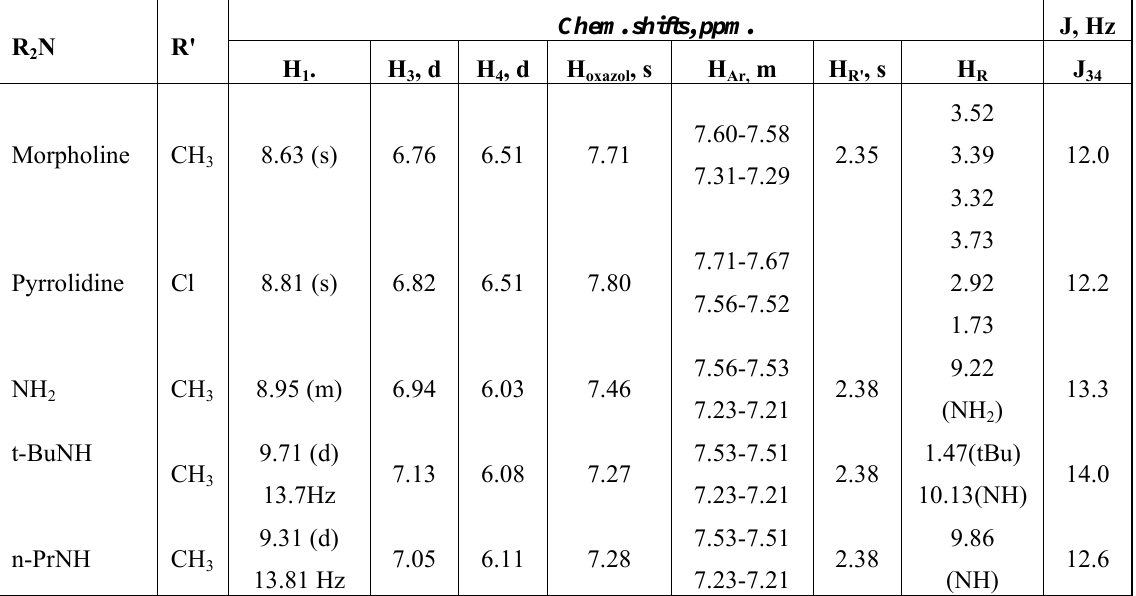
Table 3. 1 H-NMR spectra of dienes III,V. Chem. shifts,